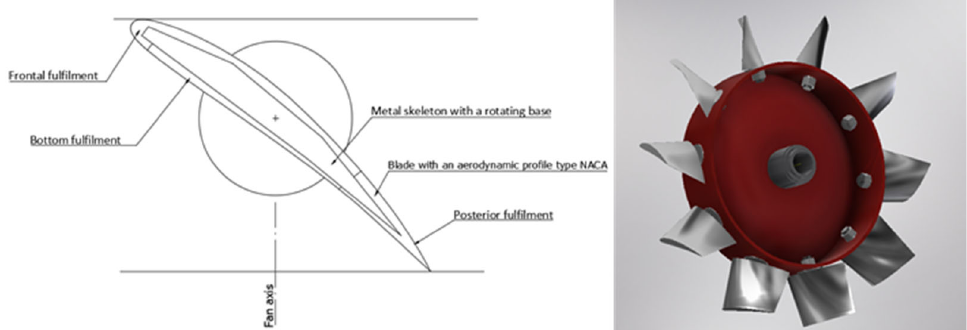
Figure 3. Conceptual design of the new blade and spatial geometric model of the rotor . Knowing the outer diameter of the rotor (0.748 m) and the diameter of the hub (0.48 m), the height of the blade (0.134 m) was determined. The area between the outer diameter of the rotor and the diameter of the hub was divided into five cross-sections (0.480; 0.547; 0.614; 0.681; 0.748 m), for which systems of the blade rim velocity vectors were